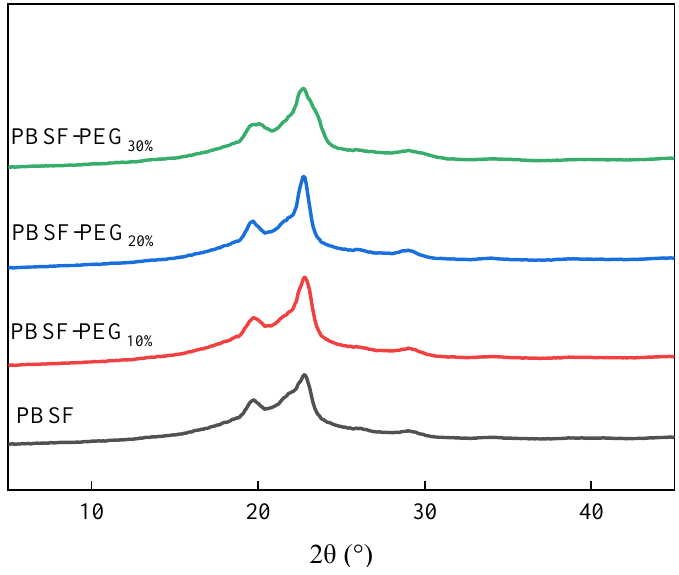
Figure 6. The WAXD pattern of PBSF and PBSF-PEG.